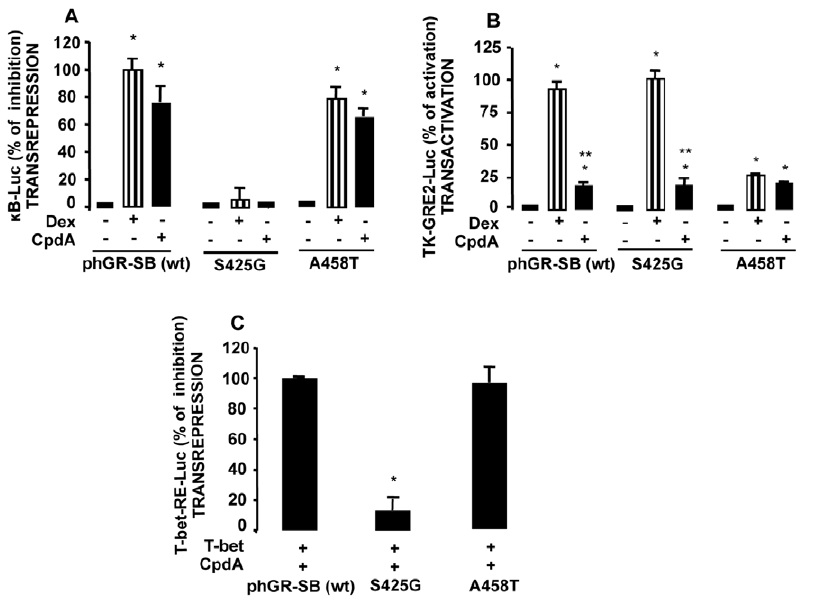
Figure 2. Compound A inhibits T-bet transcriptional activity by transrepression. A, EL4 cells were cotransfected with 9 m g of k B-Luc reporter plasmid and 9 m g of Rel A plus 9 m g of phGR-SB (wt) wild-type GR expression vectors or the GR mutants A458T or S425G. After 16 h, cells were stimulated for 8 h with IL-1 b (10 ng/ml), which induces k B-Luc activity, and with CpdA (10 m M) or Dex (100 nM). Results, as % of inhibition of k B-Luc, normalized to b -galactosidase activity, are expressed as mean 6 SEM (n = 3, * p , 0.001 vs. Rel A plus IL-1 b without Dex or CpdA), of one representative experiment of three independent experiments with similar results. B , EL4 cells were transfected with 9 m g of a reporter plasmid containing two palindromic GR-binding sites coupled to the TK promoter reporter plasmid (TK-GRE2-Luc) plus 9 m g of phGR-SB (wt) wild-type GR expression vector or the GR mutants A458T or S425G. After 16 h, cells were stimulated for 5 h with CpdA or Dex. Results, as % of activation of TK- GRE2-Luc, normalized to b -galactosidase activity, are expressed as mean 6 SEM (n = 3, * p , 0.05 vs. basal without Dex or CpdA, ** p , 0.05 vs. Dex treated wild-type or S425G mutant GR), of one representative experiment of three independent experiments with similar results. C, EL4 cells were transfected with 9 m g of T-bet-RE-Luc reporter plasmid and with 9 m g of T-bet and wild-type GR expression vectors (ph-GR-SB) or the GR mutants A458T or S425G. After 16 h, cells were stimulated for 5 h with CpdA. Results, as % of inhibition of T-bet-RE-Luc, normalized to b -galactosidase activity, are expressed as mean 6 SEM (n = 3, * p , 0.001 vs. ph-GR-SB or A458T-mediated T-bet-RE-Luc relative inhibition) of one representative experiment of three independent experiments with similar results.